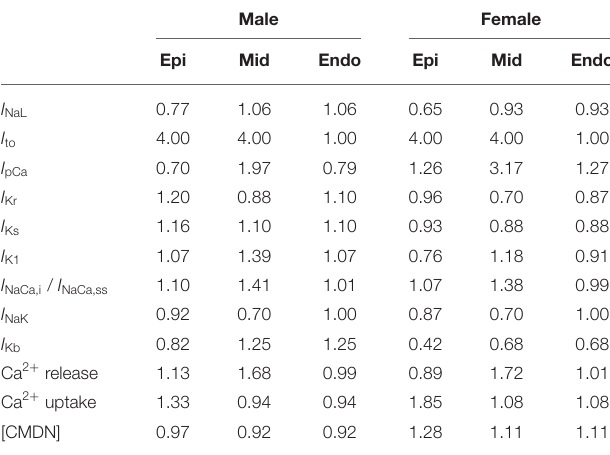
TABLE 1 | Sex-specific subcellular ion channel